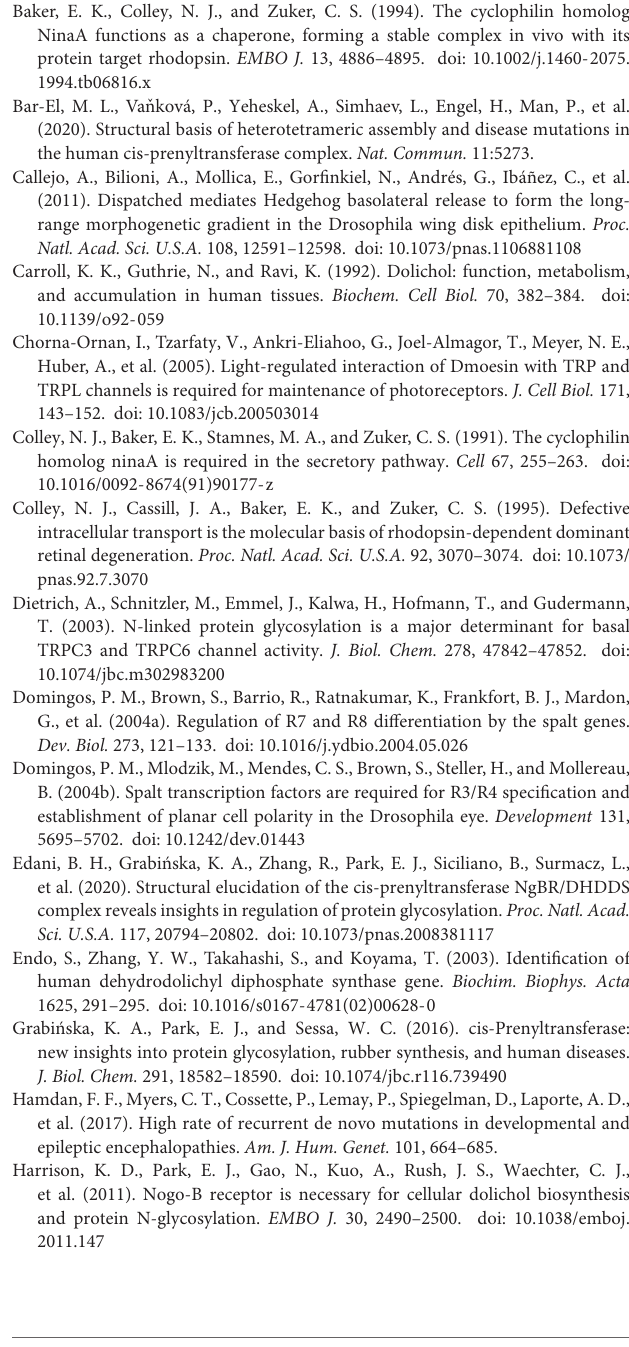
restricted to the region posterior of the morphogenetic furrow. (D) Localization of the developing photoreceptors . Note that the expression of the developing